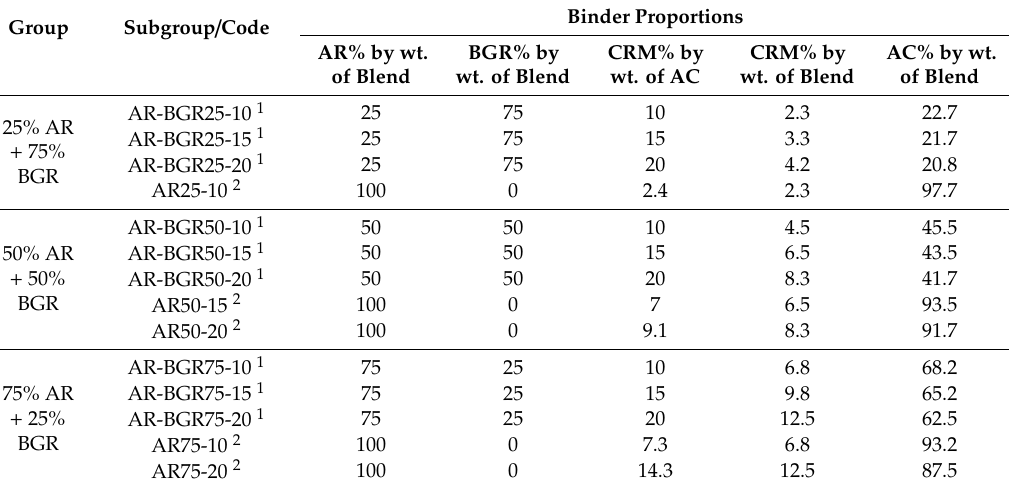
Table 1. Experimental groups, subgroups, coding, and detailed proportions.